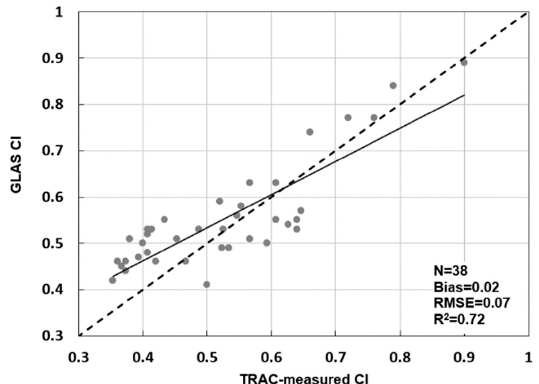
Figure 8. Evaluation of the GLAS CI derived from GLAS data with low slope and good data quality using TRAC-measured CI. The solid line represents the linear fits of the TRAC measurements with GLAS CI.